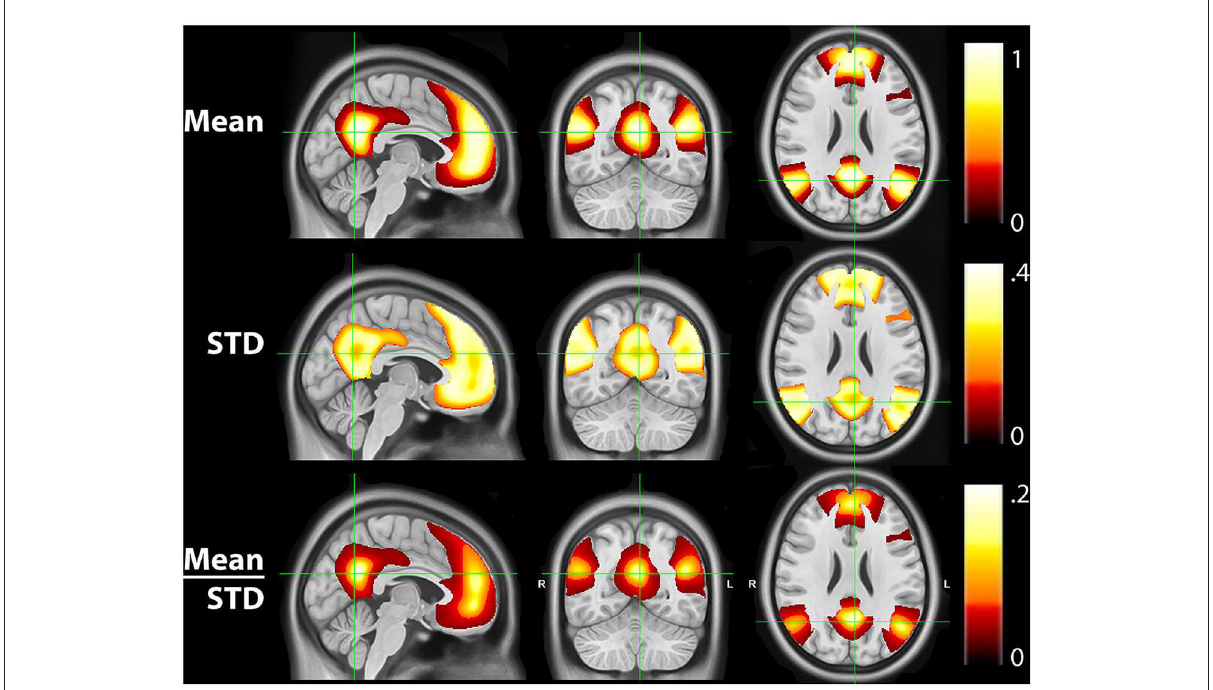
FIGURE4 Mean, standard deviation (STD), and mean/STD probability maps for the default mode network (DMN). The mean results show a large number of voxels with high probabilities. STD maps show the majority of voxels have a relatively high STD. When scaling the mean values by the STD, the regions with high relative probabilities becomes significantly